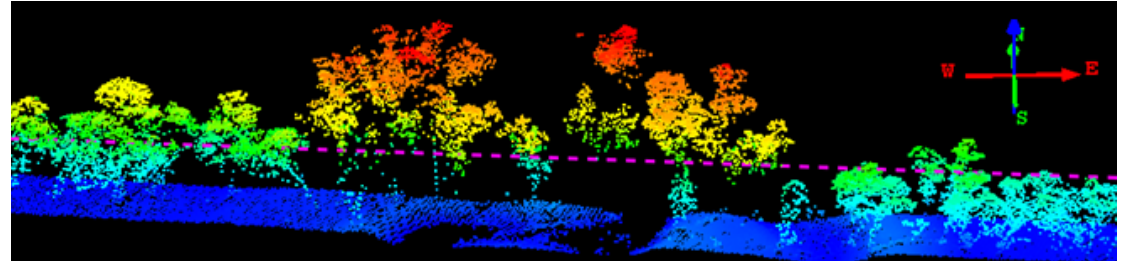
Figure 3. Example of acquired LiDAR data (discrete returns extracted from waveform data) depicting how the system failed to acquire information about tree trunks